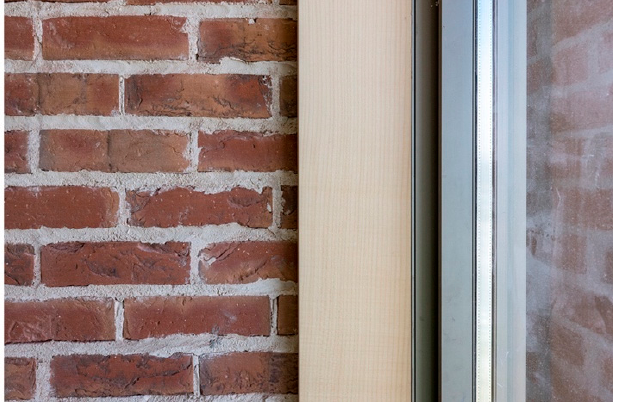
Figure 19. Vila Nova de Gaia. ©João Ferrand.